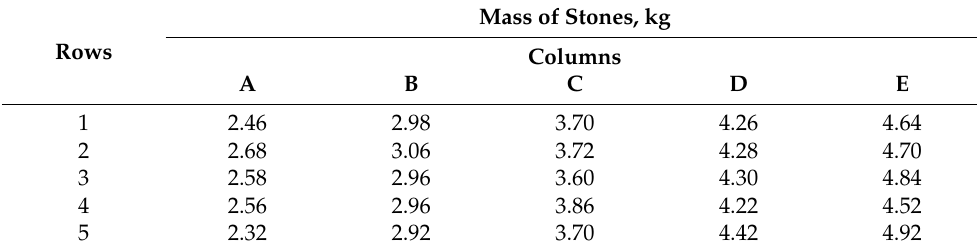
Mass of Stones, Mass of Stones, kg